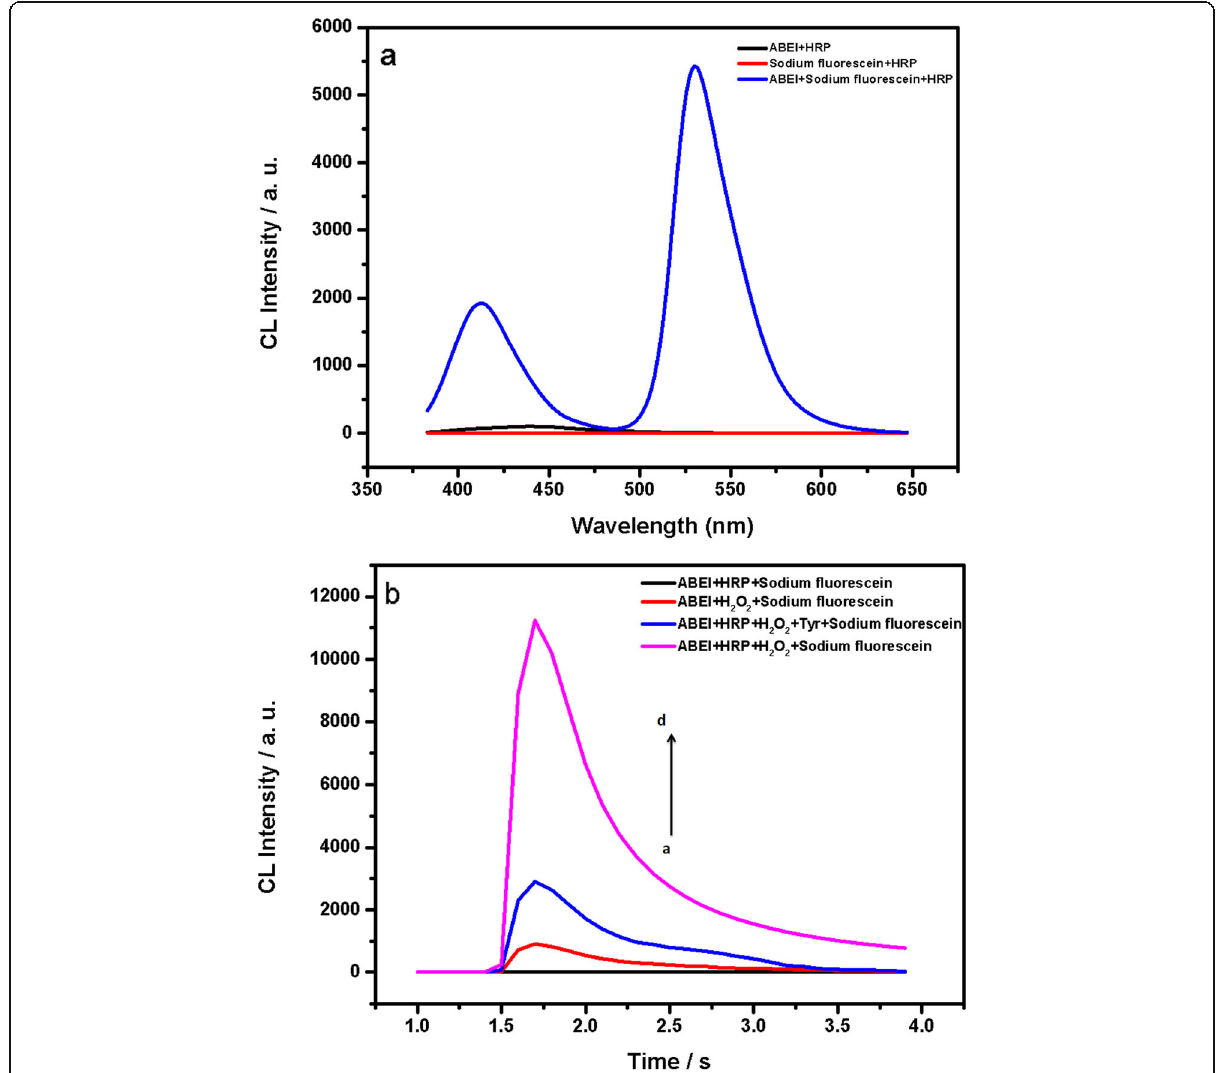
Fig. 1 a CL kinetic curves of sodium fluorescein-HRP (red curve) with H 2 O 2 , ABEI-HRP-sodium fluorescein (blue curve) with H 2 O 2 , and HRP-ABEI (black curve) with H 2 O 2 ; b ABEI+HRP+sodium fluorescein (curve a), ABEI+H 2 O 2 +sodium fluorescein (curve b), ABEI+HRP+H 2 O 2 +Tyr+sodium fluorescein (curve c), and ABEI+HRP+H 2 O 2 +sodium fluorescein (curve d) CL kinetic curve of